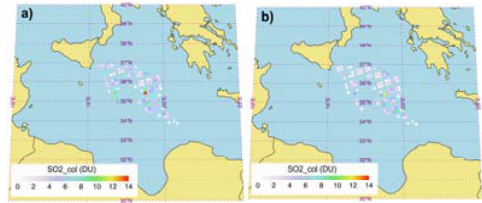
Figure 2: IASI 10 April 19.43 GMT SO 2 column amount: a) UNIOX and b) ULB.